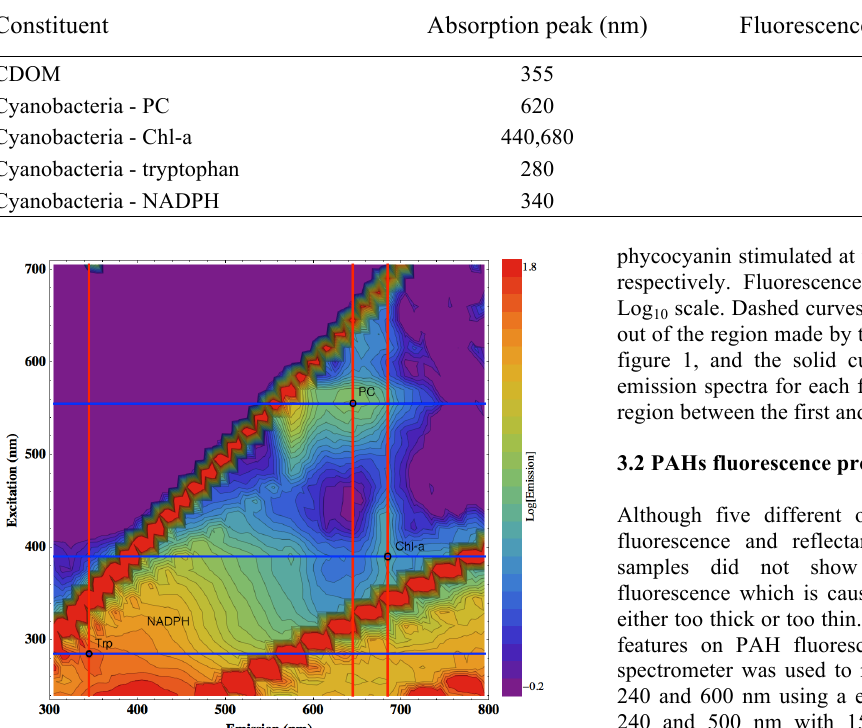
Table 1. Fluorescence properties of seawater containing CDOM and cyanobacteria.